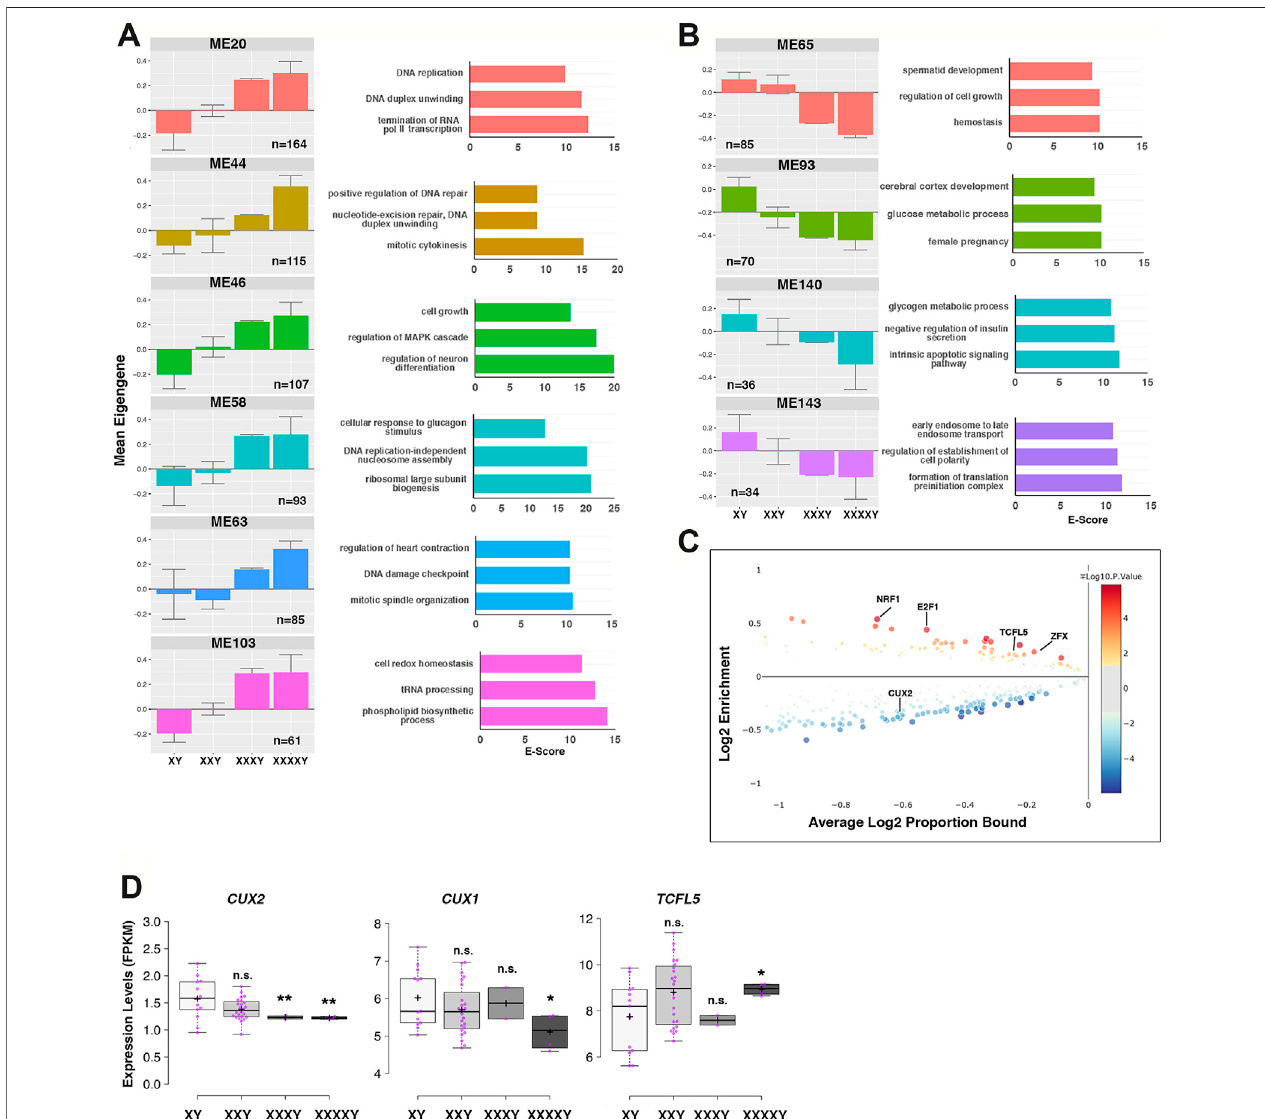
FIGURE6| WGCNA oftheeffects ofsexchromosomedosageontheglobaltranscriptome. (A) Histogramplotsshowingthemeanexpression( ± 95%con fi dence) by genotype for sixselected proportional X chromosome dosage-dependent gene co-expression modules (left) and enrichmentscores(E scores) of the top three Gene Ontology (GO) terms (right) for each of the ten selected supermodules. (B) Histogram plots showing the median expression ( ± 95% con fi dence) by genotype for four inversely proportional X chromosome dosage-dependent gene co-expression modules (left) and enrichment scores (E scores) of the top three GO terms for each module (right). (C) CiiiDER enrichment analysis showing the transcription factor binding sites (TFBSs) that are signi fi cantly over-represented (greater than zero) and under-represented (less than zero) for the supermodule ME48compared with thebackground sequences. The plot shows the proportion ofregions bound for each TF. The y-axis shows the enrichment (ratio of proportion bound) and the x-axis shows the average log proportion bound. The sizes and colors of the circles indicate the ± log10( p value). (D) FPKM expression values of CUX1 , CUX2 and TCFL5 TFs in iPSCs in the indicated karyotypes. Each purple dot represents an RNA-Seq replicate. Centerlines show the medians; box limits indicate the 25t h and 75th